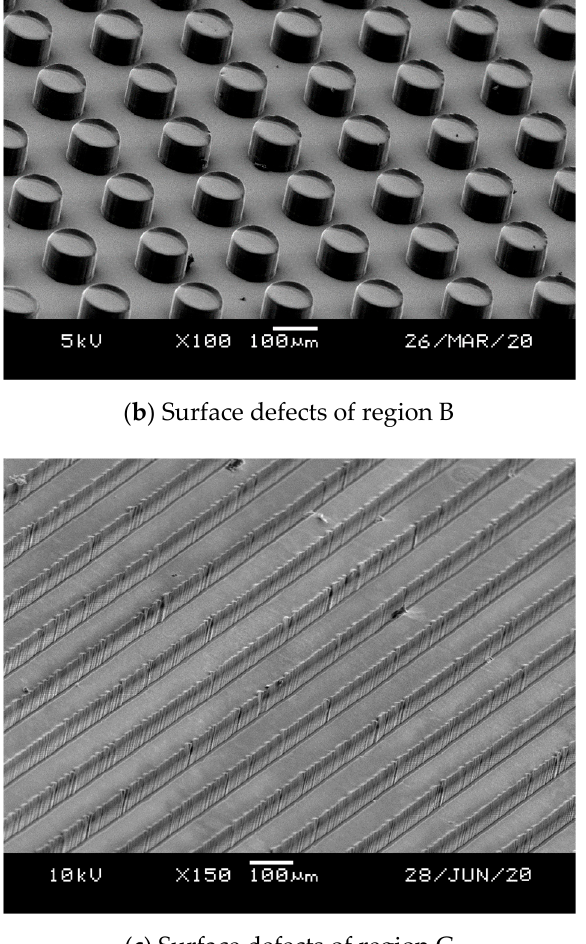
Figure 9. Surface defects in the microstructure patterns on region A, B, and C. (When the embossing pressure and embossing time were maintained at 30 kg cm − 2 and 120 s, the practical embossing temperatures of zones A, B, and C were set to 179.5, 181.5, and 182.7 °C, respectively.).